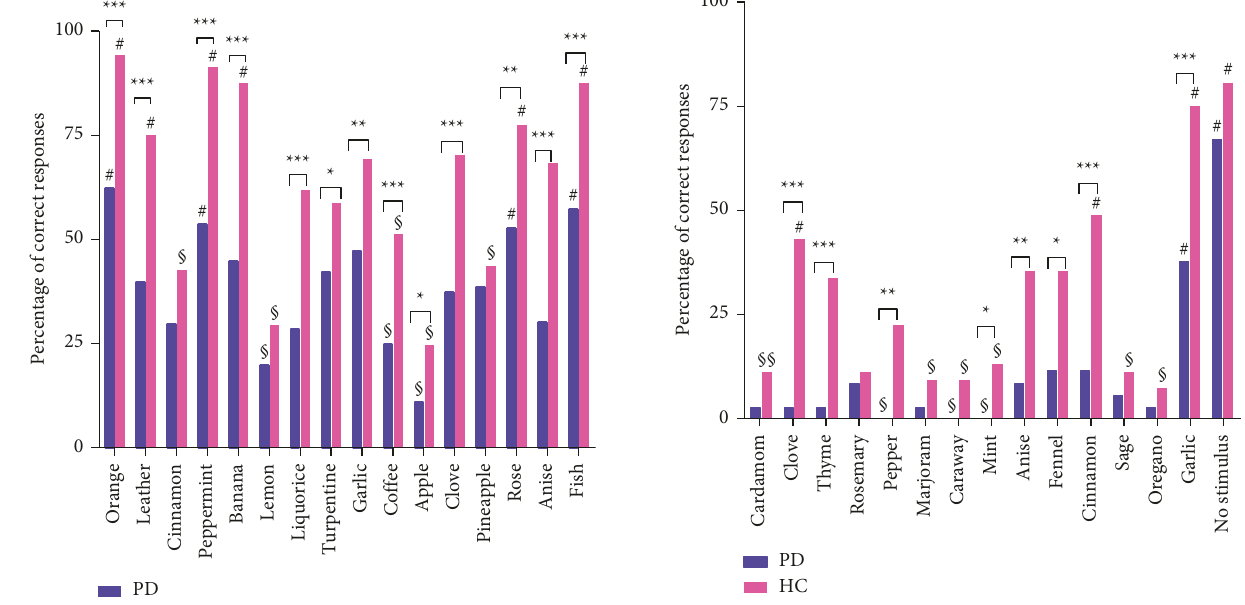
Figure 2: Responses of Parkinson’s patients and healthy controls for the spice odor identification test; HC, healthy controls; PD, Parkinson’s disease patients; ∗ p < 0.05; ∗∗ p < 0.01; ∗∗∗ p < 0.001; # an odorant that is better recognized compared with the other odorants within the specific population group; §, an odorant that is least recognized compared with the other odorants within the specific population